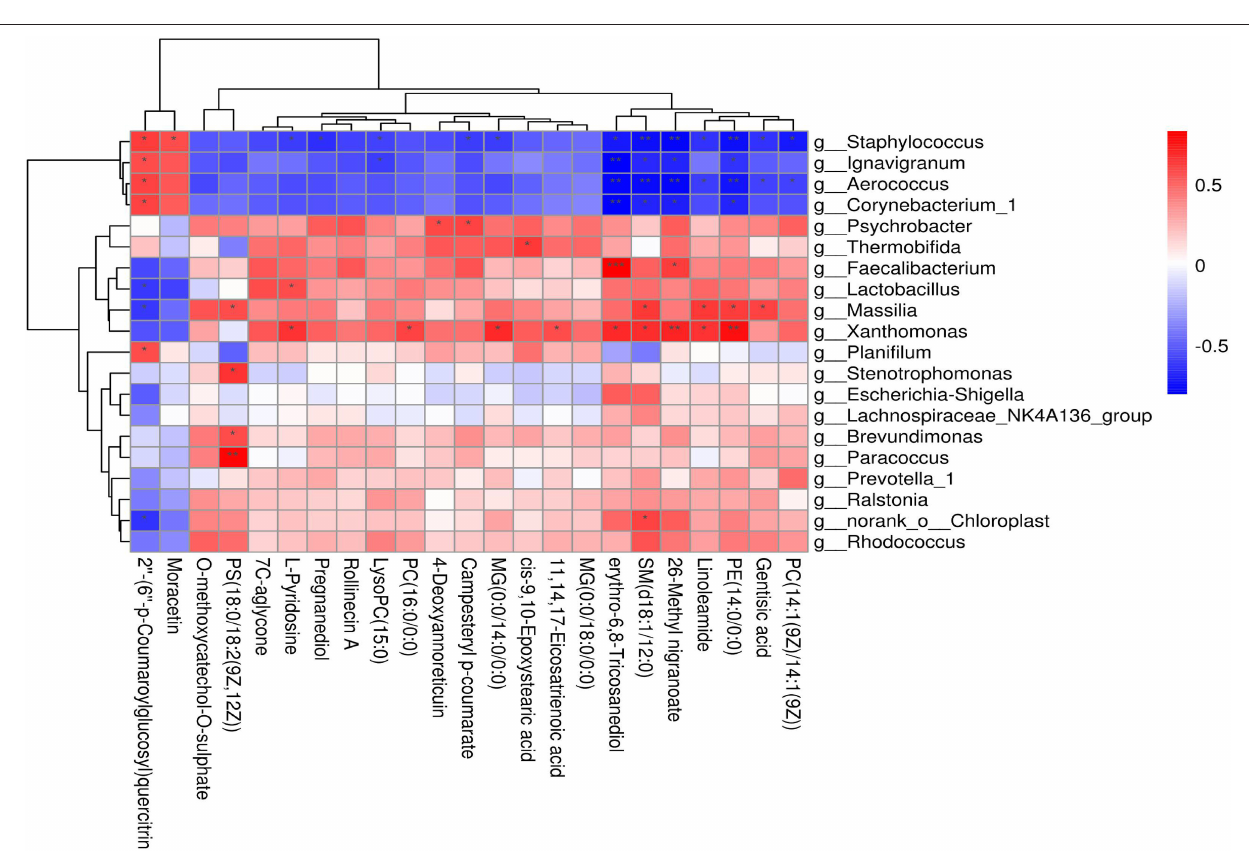
FIGURE 8 | Correlation analyses between milk bacteria genus and altered metabolite levels in the CON and AOB groups. Each row in the graph represents a genus, each column represents a metabolite, and each lattice represents a Pearson correlation coefficient between bacteria and metabolites. Red represents a positive correlation, while blue represents a negative correlation (*0.01 < p < 0.05; **0.001 < p ≤ 0.01; *** p <